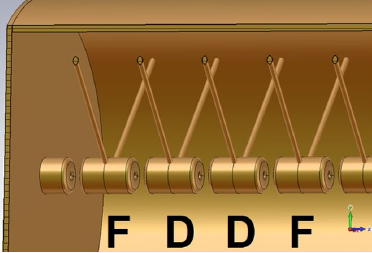
FIG. 1. One complete DTL period comprising four quadrupoles and four rf gaps.